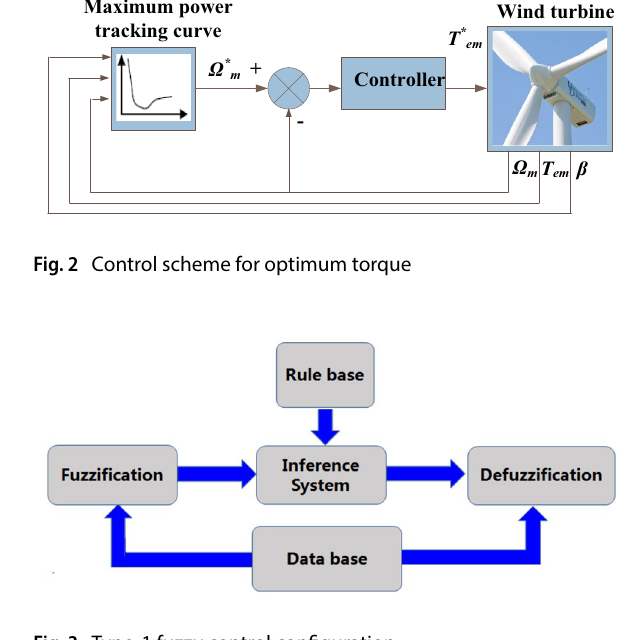
Fig. 3 Type-1 fuzzy control